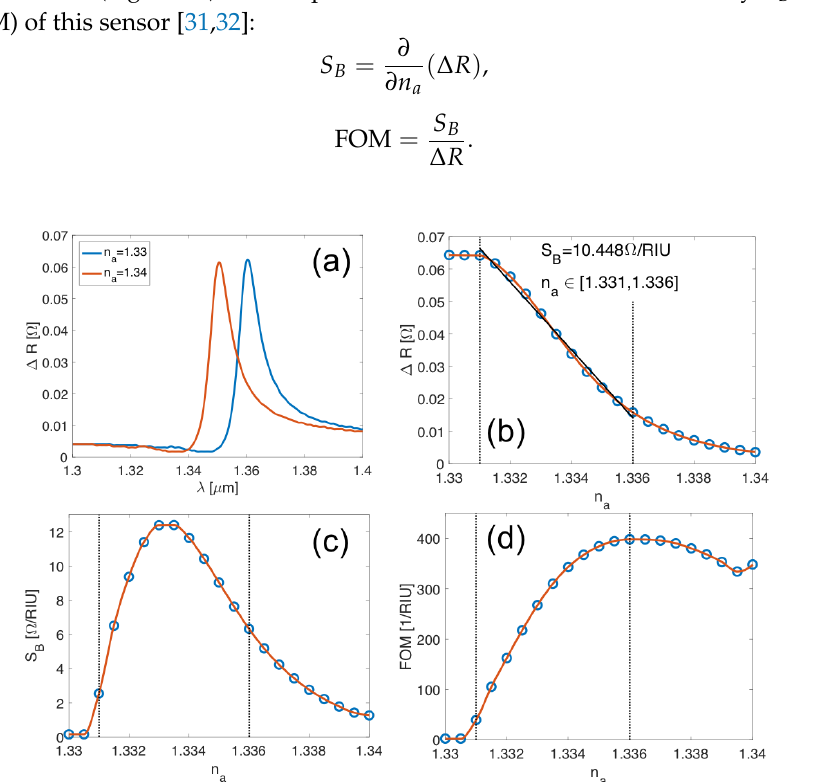
Figure 4. ( a ) Variation of the resistance of the structure as a function of wavelength. ( b ) Variation of the resistance with the index of refraction of the analyte when the structure is illuminated on resonance ( λ = 1.351 µ m). The linear fitting in the interval n a ∈ [ 1.331,1.336 ] defines a value of sensitivity, S B = 10.45 Ω /RIU (where RIU means refractive index units). ( b ) Variation of the sensitivity, S B , as a function of the index of refraction of the analyte, n a . ( d ) Dependence of the FOM in terms of n a . The open circles in ( b – d ) denote the evaluated values, and the solid lines represent an interpolation of these dependences. The vertical dotted lines in ( b – d ) show the range in the index of refraction, n a , where the system is